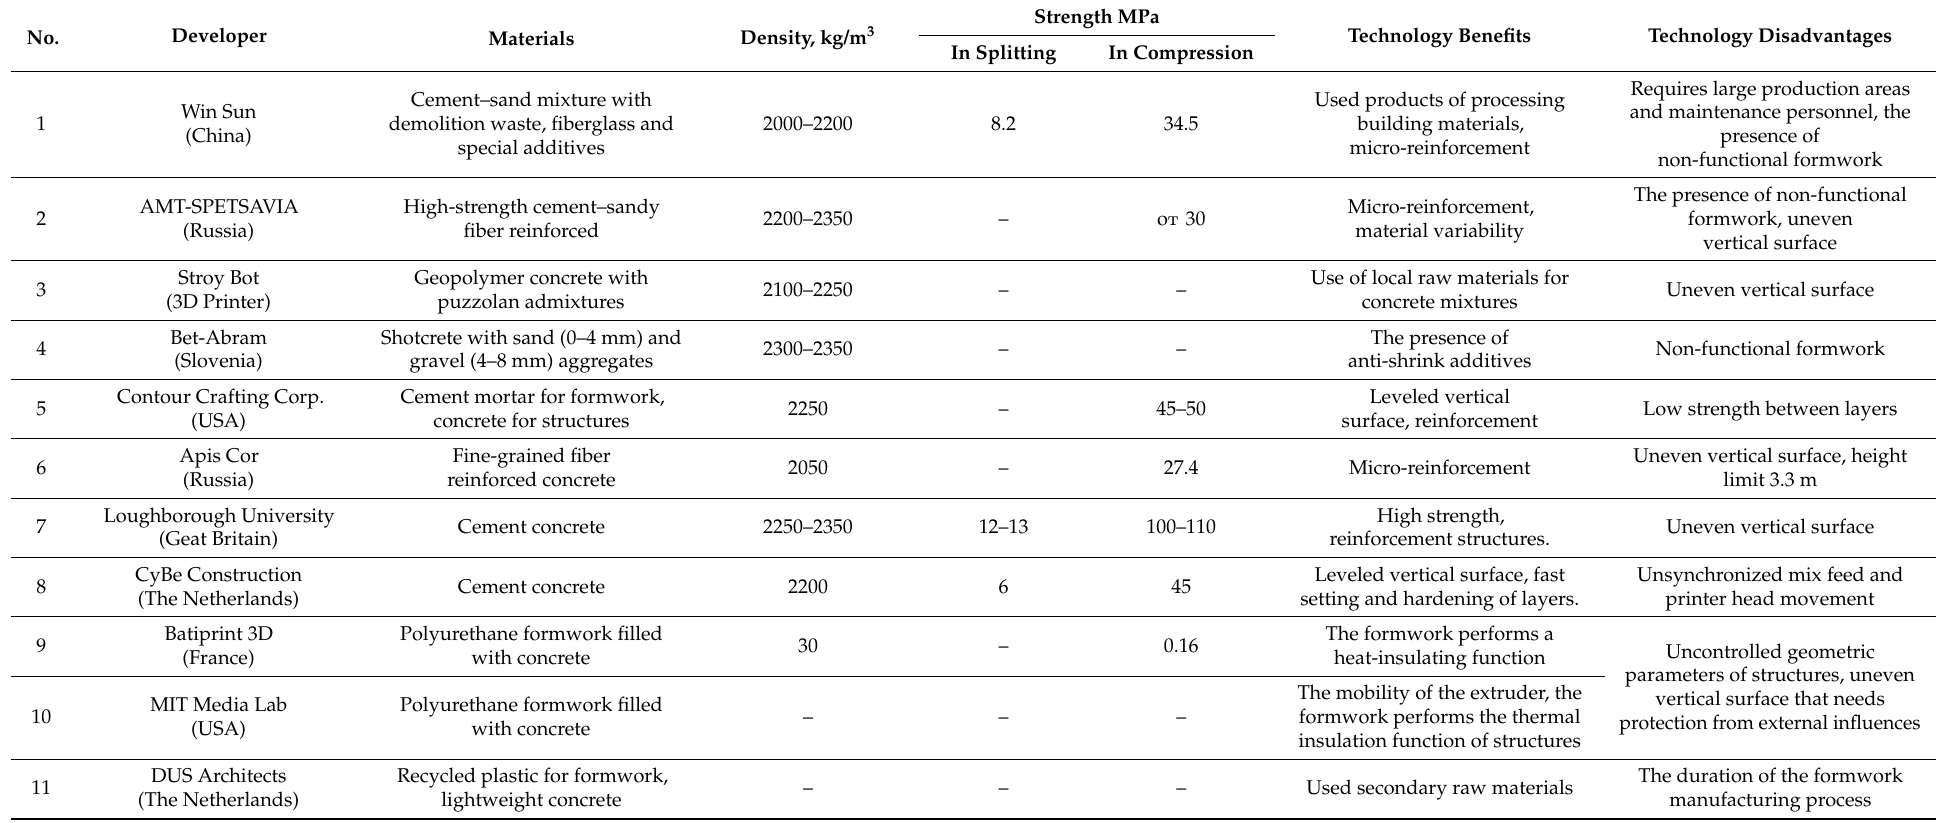
Table 1. Recommended building mixes for 3D